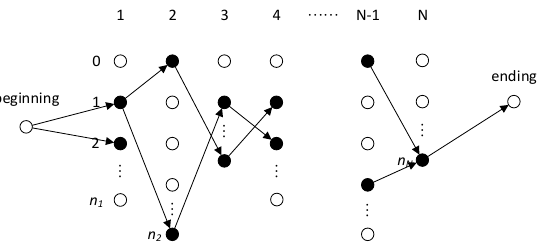
Figure 8. Genetic algorithm result conversion.